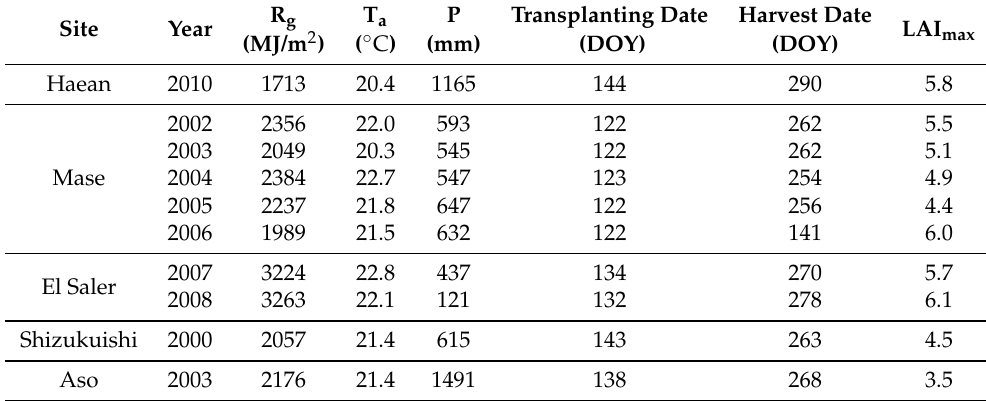
Table 1. Site information and meteorological conditions at Haean (HK, S. Korea), Mase (MSE, Japan), Shizukuishi (Japan), Aso (Japan), and El Saler-Sueca (ESES2, Spain). R g is the total global radiation, T a is the mean air temperature, and P is the sum of rainfall over the crop growth period (from transplanting date to harvest date). LAI max indicates maximum